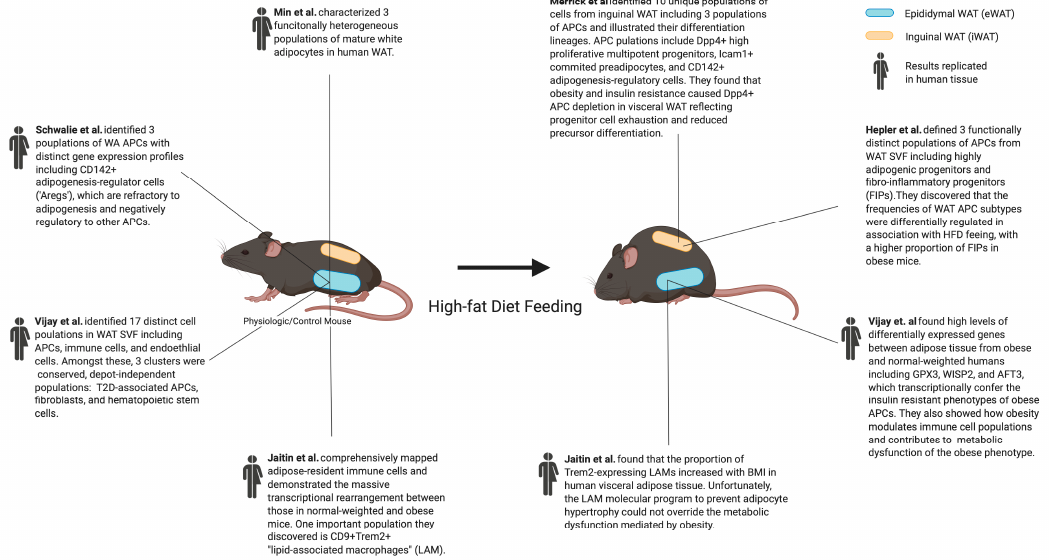
Figure 2. Single-cell genomics uncovers cellular heterogeneity in the adipose tissue and phenotypic changes during obesity.